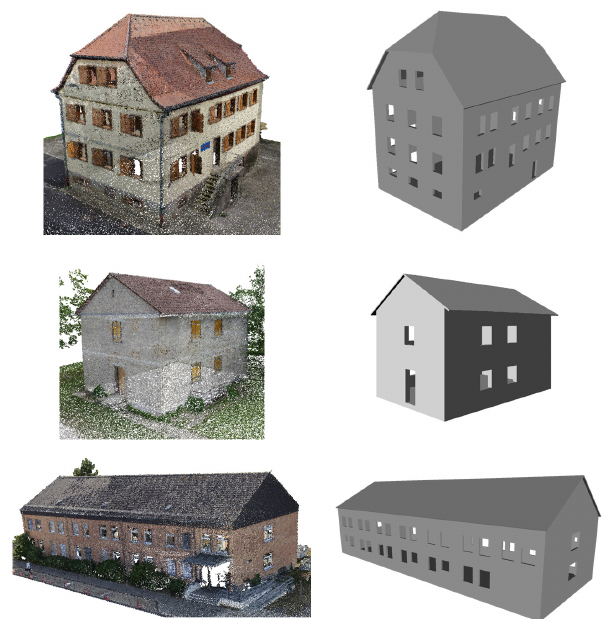
Figure 10. Input point clouds (left) and reconstruction results (right).